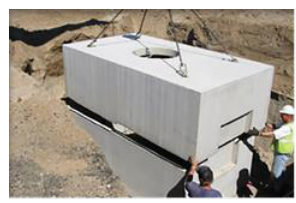
Figure 1. Underground cable wells.